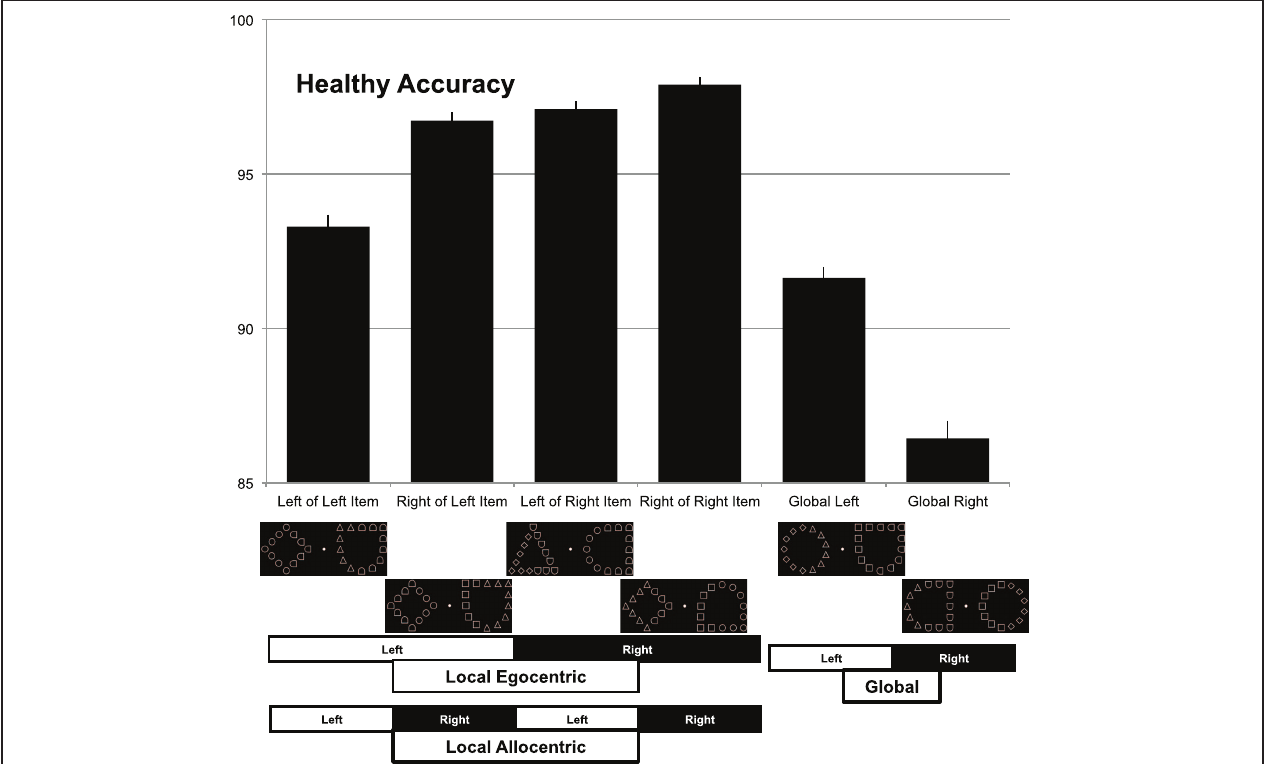
FIGURE 2 | Performance for healthy individuals performing this task. Percent accuracy for targets appearing at different locations (left vs. right) and different scales (local vs. global). The task was to press a green button whenever a circle was present, regardless of whether this was a local feature (four leftmost columns) or a global feature (two rightmost columns), and to press a red button if there was no circle present (not shown). Bars show performance for different target locations, with example displays shown